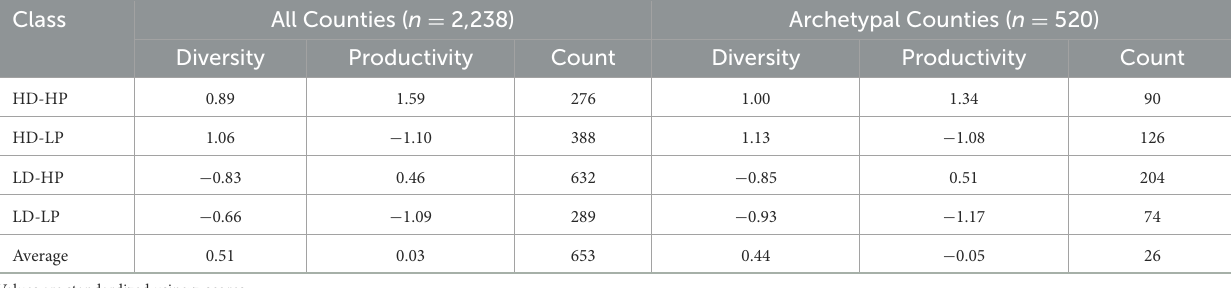
TABLE 1 Class means for diversity and productivity and count of counties with complete agricultural system attribute information in each class for all counties and for the subset of archetypal counties . Class All Counties ( n = 2,238)